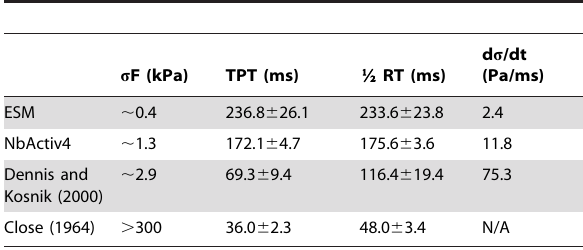
Table 2. Contractile properties of NbActiv4 cultured muscle versus previous results and published